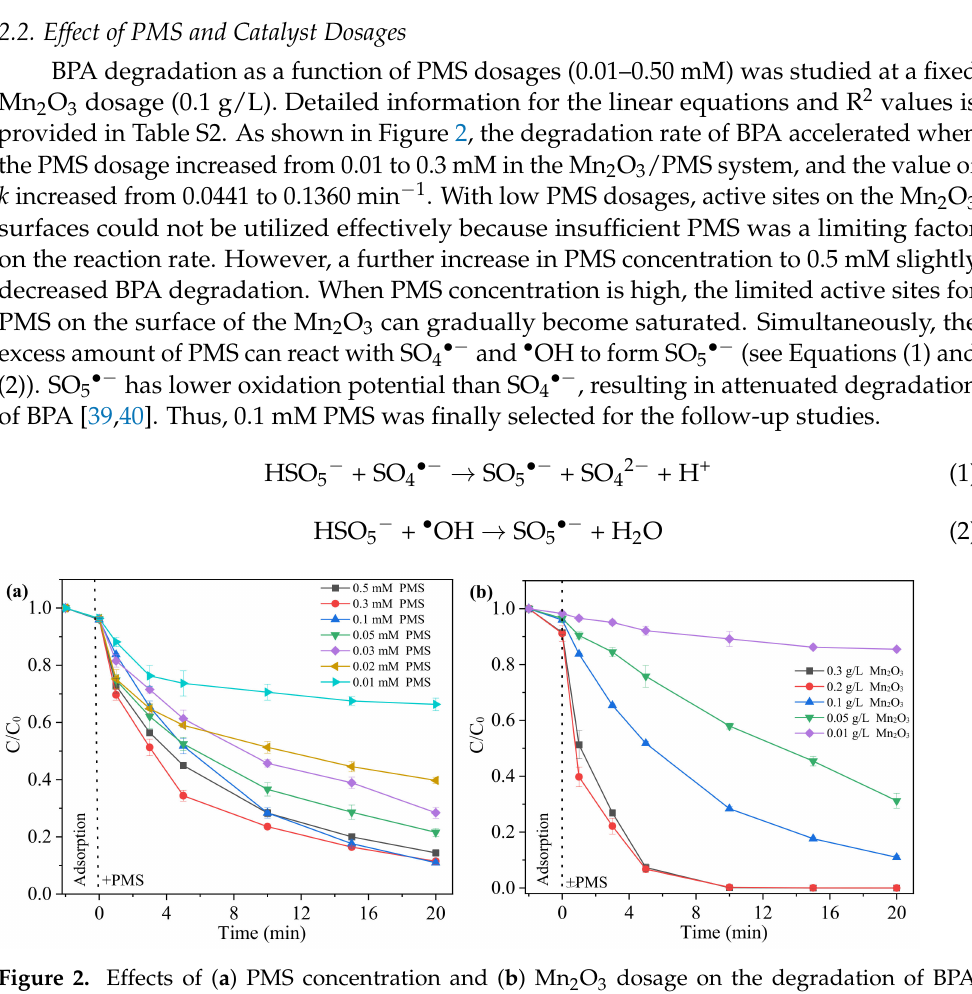
Figure 1. Effects of catalyst sizes on BPA removal efficiencies in ( a ) adsorption by Mn 2 O 3 and ( b ) degradation by the Mn 2 O 3 /PMS system. Reaction conditions: [BPA] 0 = 10 mg/L, [PMS] 0 = 0.5 mM, [Mn 2 O 3 ] 0 = 0.1g/L, initial pH = 7.0 ± 0.2.